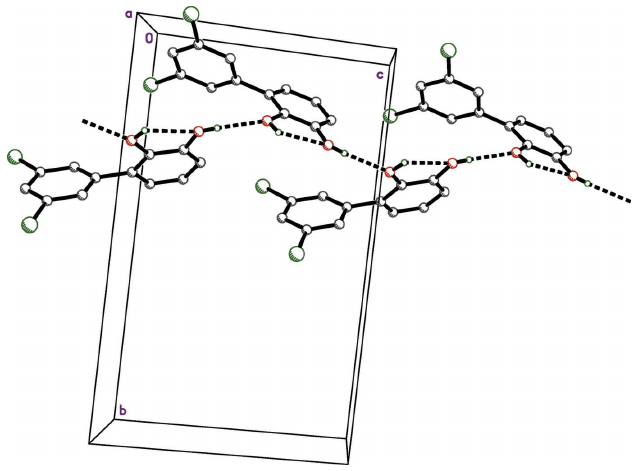
Figure 2 A packing plot viewed approximately along the a axis. Intra- and intermolecular hydrogen bonds are drawn as thick dashed lines. For information regarding the hydrogen-bond geometry, see Table 1.